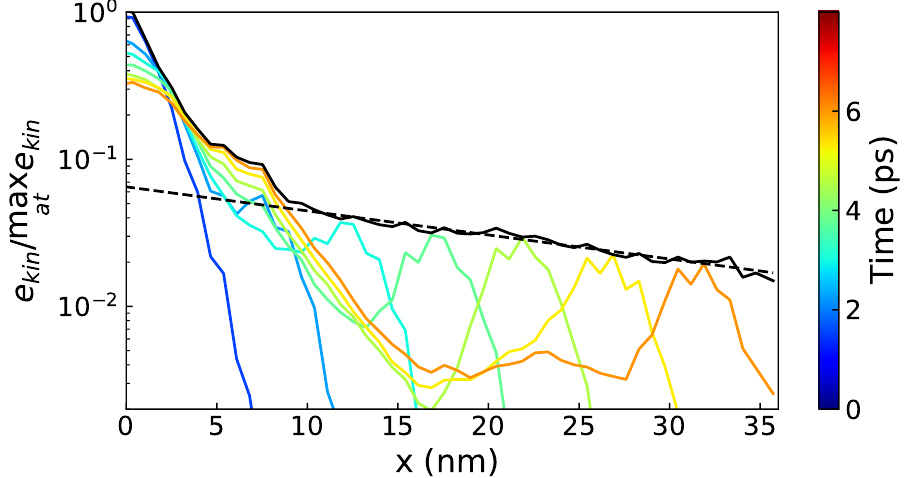
Figure 1. Representation of the propagation of an 8 THz longitudinal impulsion in the NW-M, with the energy distribution at different time steps (colored lines), the envelope defined as the maximal value of the kinetic energy at a given position (black solid line) and the exponential fit used to compute the MFP (dashed black